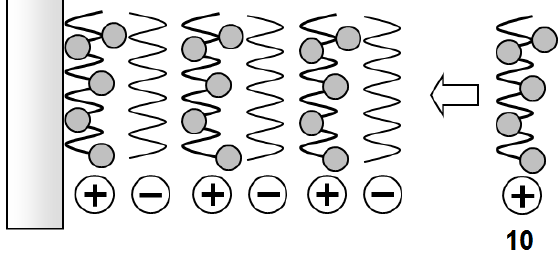
Figure 12. Schematic illustration of fabrication of layer-by-layer films using dye 10